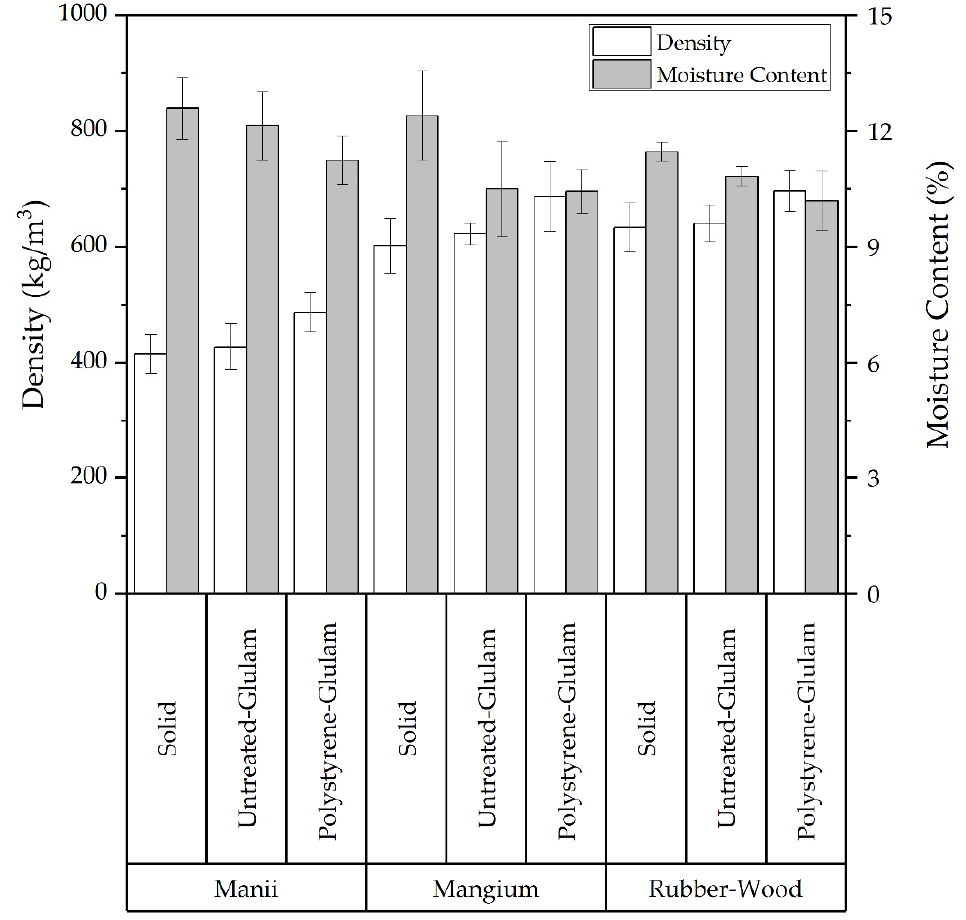
Figure 3. Density and moisture content of each wood species and wood product. Table 2. Variance analysis summary of physical properties.